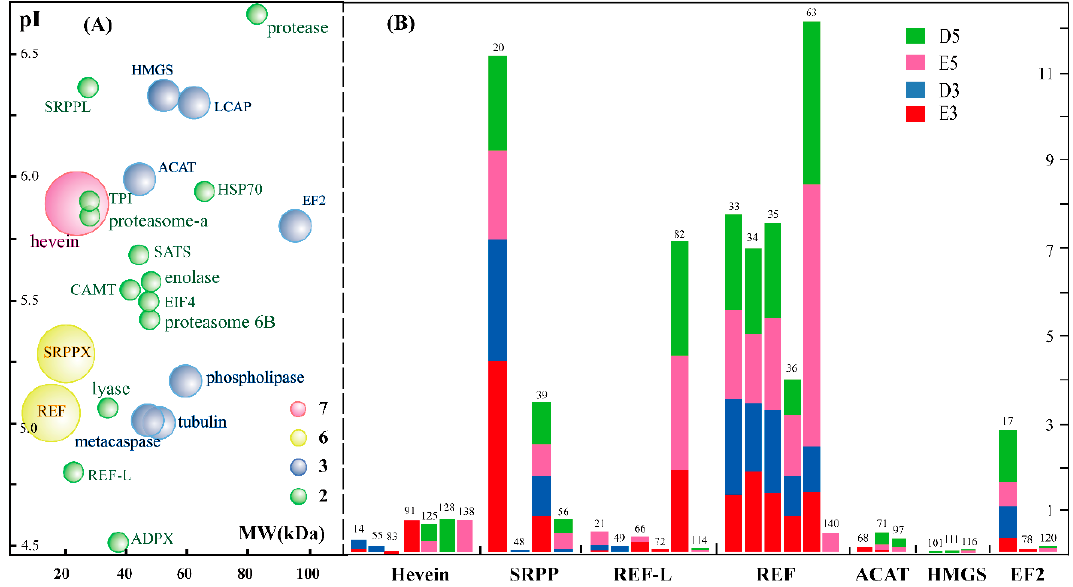
Figure 3. Bubble diagram of all the protein isoforms and comparison of the changed abundance of 2-DE gels upon ethylene application. The glycosylated proteins with at least two isoforms are highlighted as 23 bubbles from 65 protein spots. The bubbles with di ff erent sizes and colors stand for di ff erent number of protein isoforms identified from di ff erent spots ( A ). The accumulation patterns of 7 glycoprotein proteins containing 32 isoforms in the 2DE gels for total rubber latex from the rubber tree treated with water and ethylene for three (D3, E3) and five days (D5, E5) are provided ( B ). The number in the top of the histogram stands for the protein spot number in the 2-DE gels.